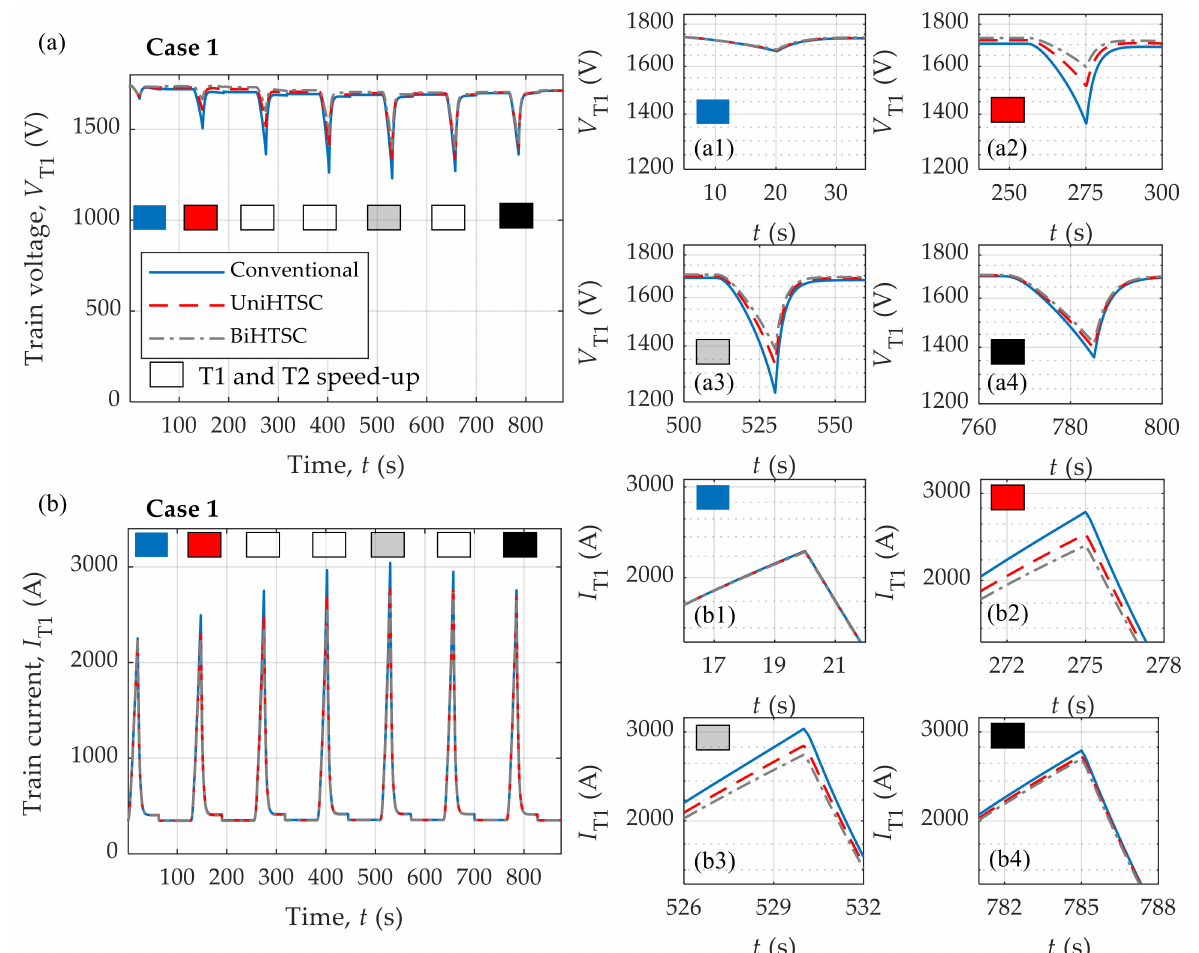
Figure 21. Comparison of the voltage and current of train T1 for the 3 cases: conventional, UniHTSC and BiHTSC. ( a ) the pantograph voltage of train 1 for scenario 1, ( b ) the current drawn by train T1 for scenario 1. Right side: ( a1 – a4 ) and ( b1 – b4 ) show some magnified figures of the current and voltage of the train at different